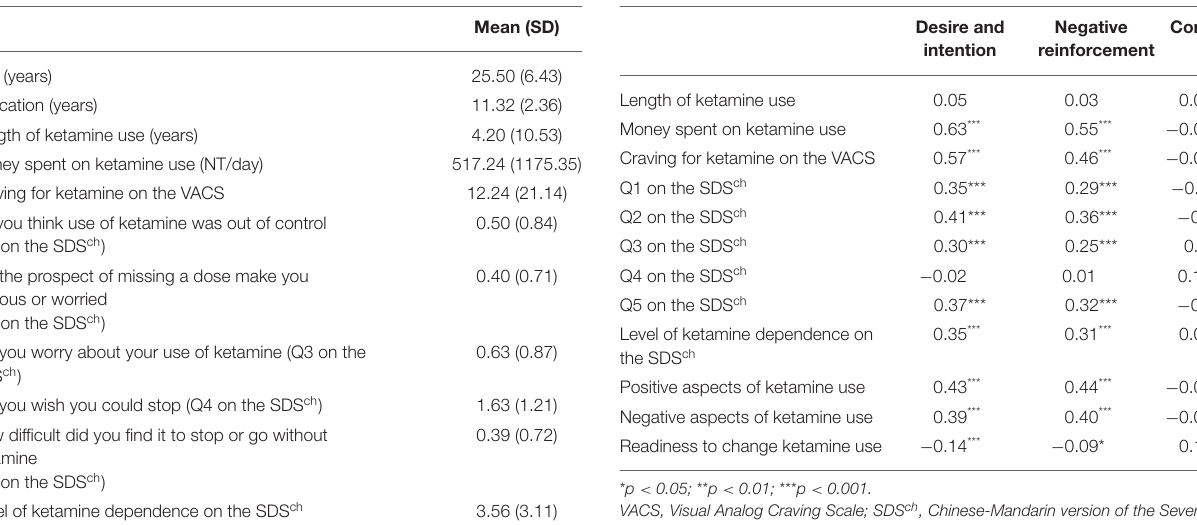
TABLE 1 | Demographic and ketamine-related characteristics of male ketamine users.